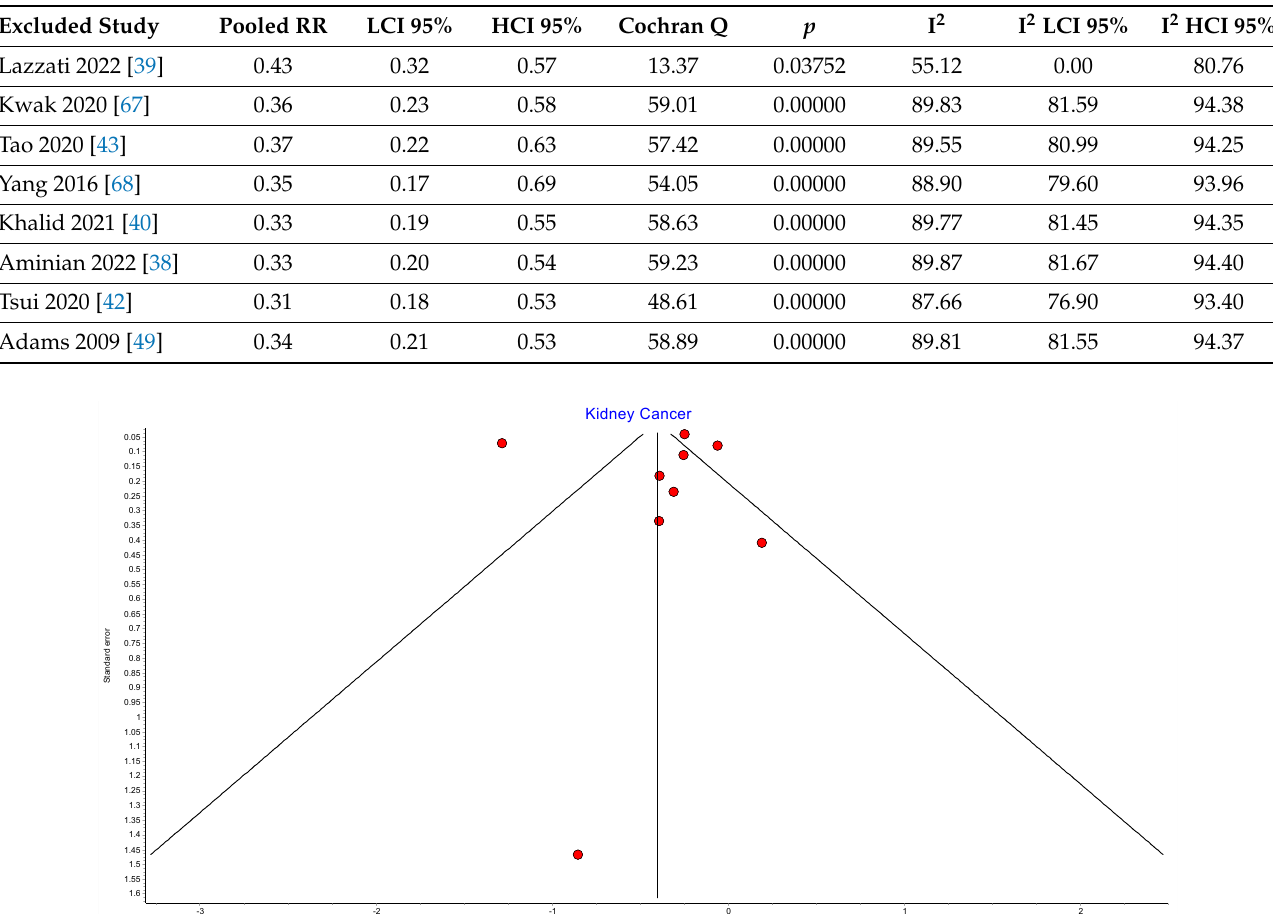
Table A13. HCC random effects model sensitivity analysis.